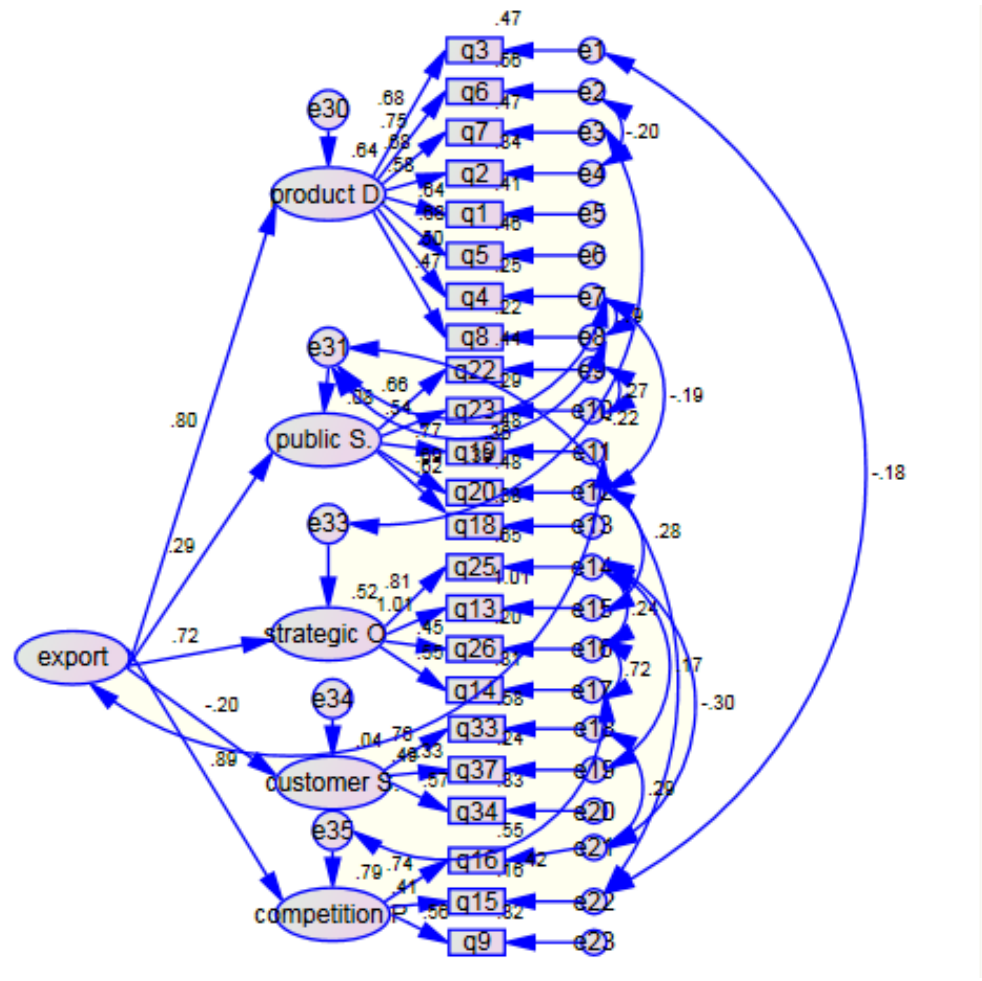
Fig. 3. The results of standard coefficients on structural equation